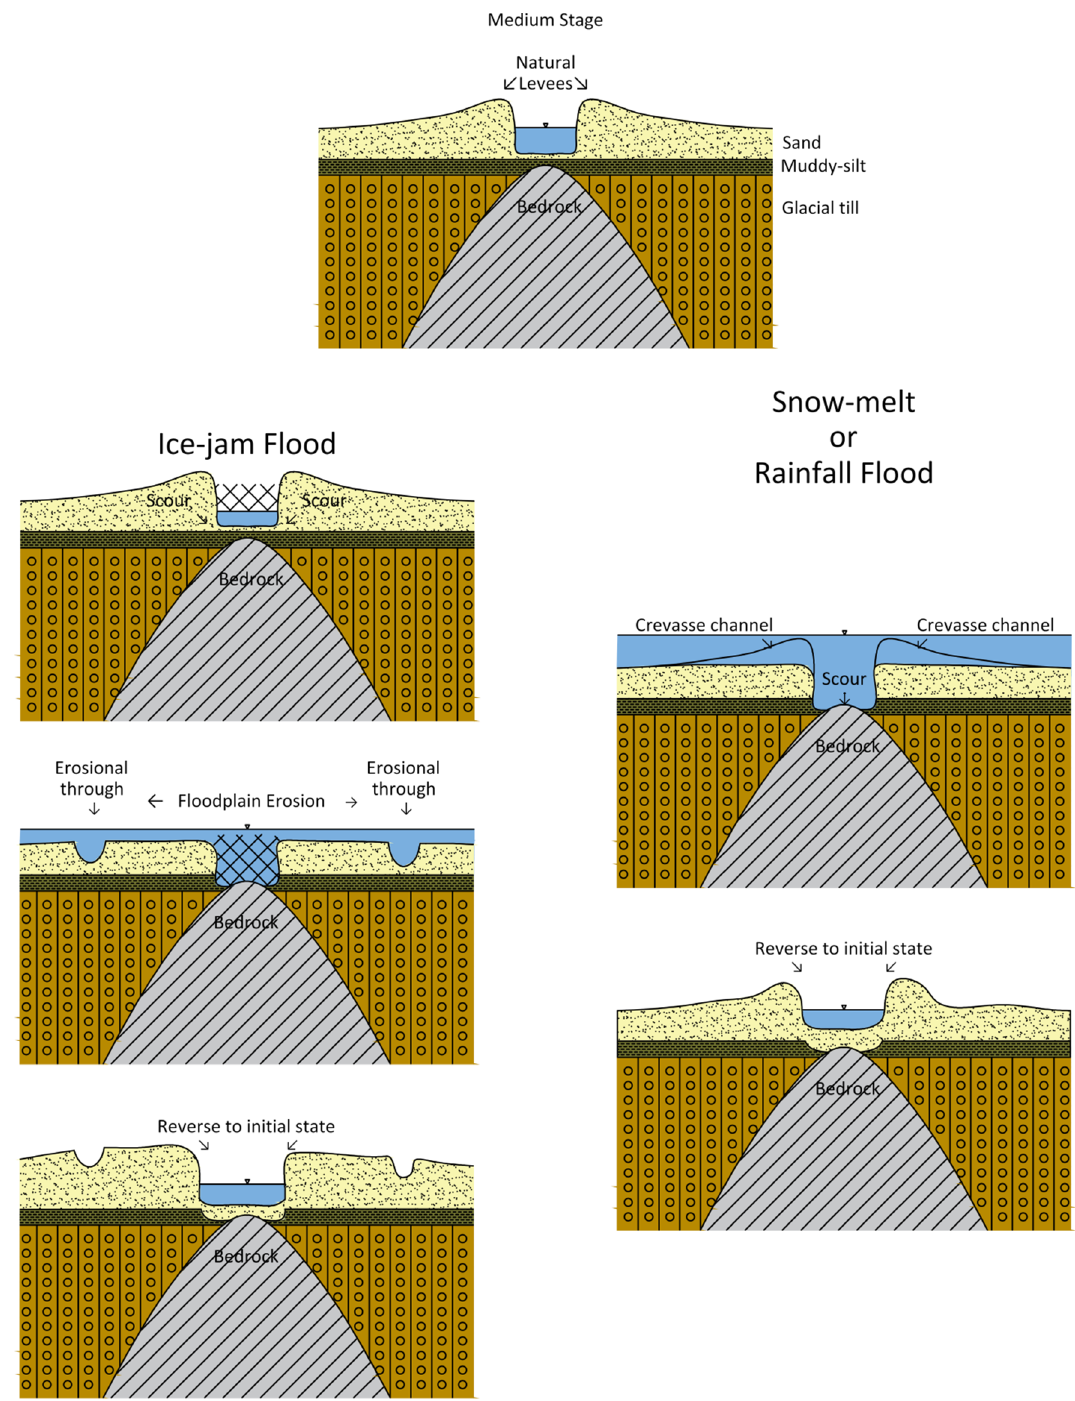
Figure 8. Idealized, schematic geological cross-section of the large, alluvial river valley with the river channel anchored atop bedrock (or non-alluvial protrusion) during the ice-jam floods (on the left) and snowmelt or rainfall floods (on the right).